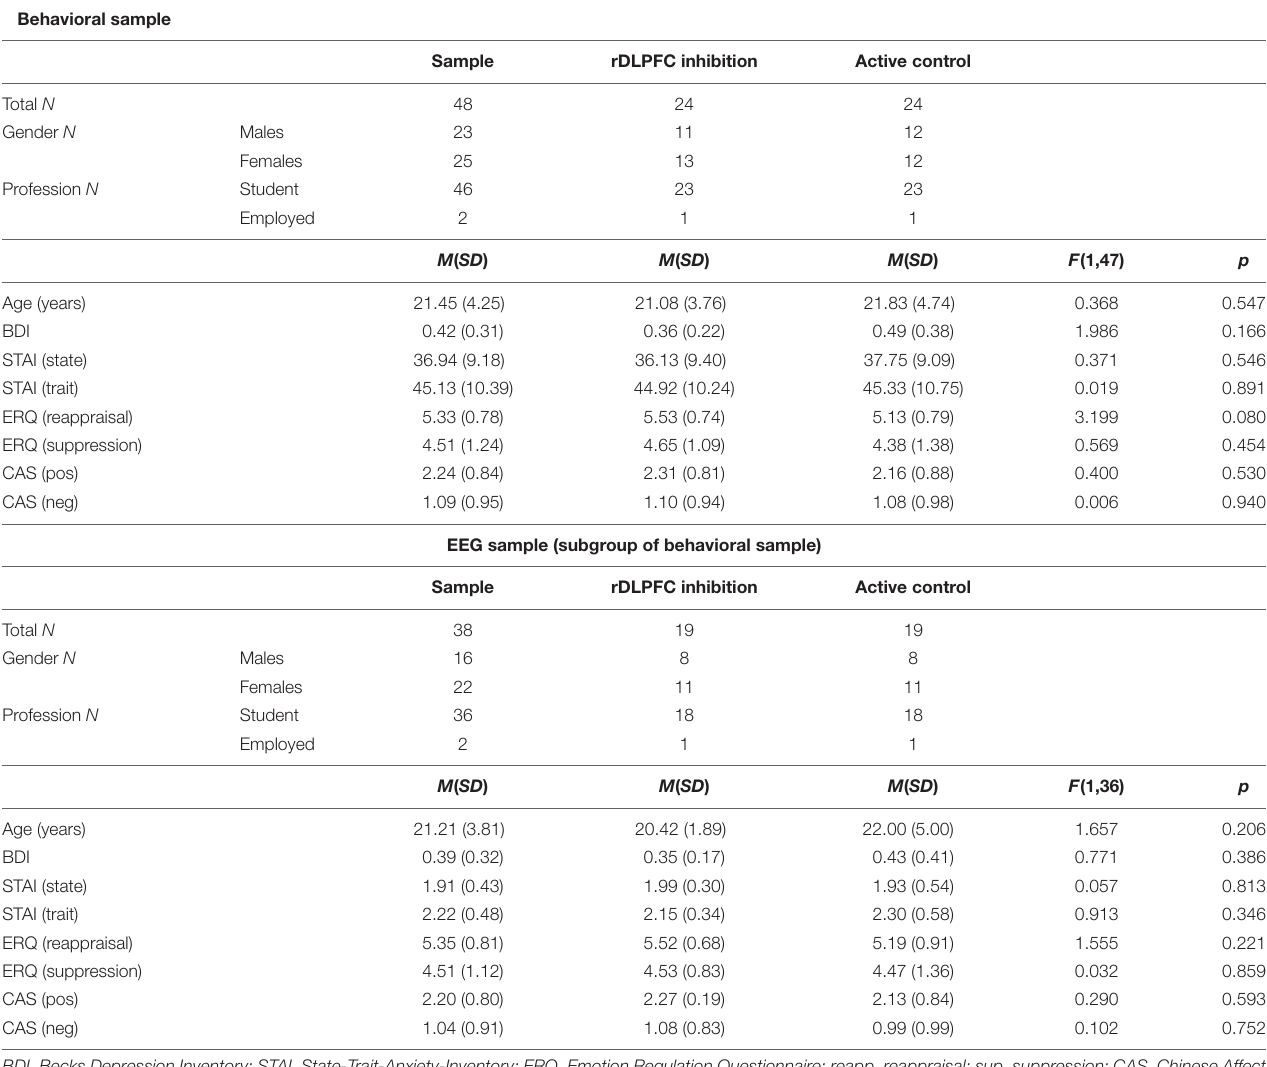
TABLE 1 | Description of the EEG and the Behavioral